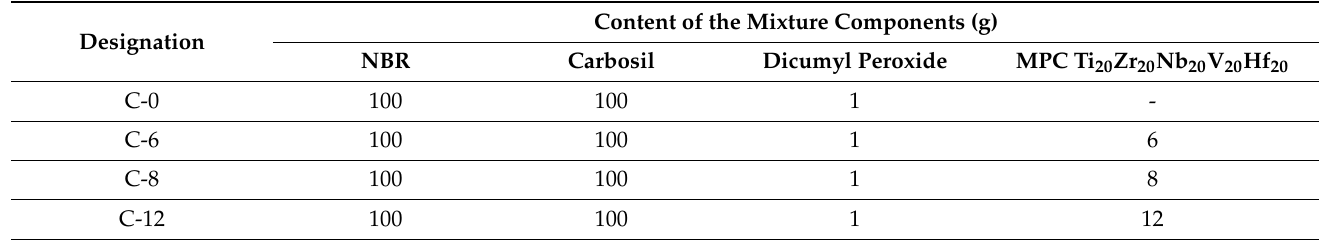
Table 1. Designations and components for the four obtained composite